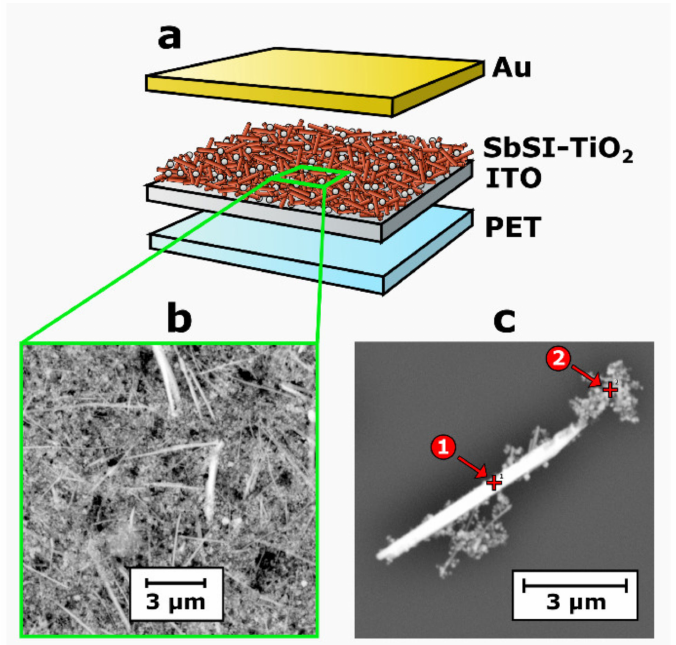
Figure 2. The layer structure of the pyroelectric nanogenerator ( a ), SEM micrograph of the SbSI–TiO 2 film ( b ), and a selected nanowire ( c